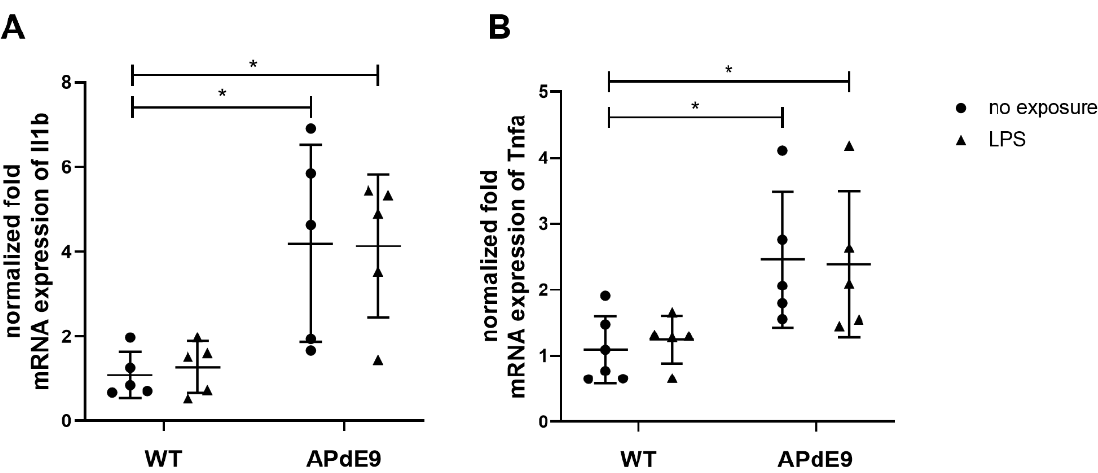
Figure 3. Comparison of normalized fold mRNA expression of pro-inflammatory cytokines interleukin-1 beta (Il1b) ( A ) and tumor necrosis factor alpha (Tnfa) ( B ) in the cerebral cortical tissue in saline-treated female wild-type (WT) control mice vs. female WT mice treated with LPS, and female APdE9 mice treated with either saline or LPS. The line represents group mean and whiskers — the SD ( n = 4 – 6 per group). The statistical significance of changes in gene expression between the groups